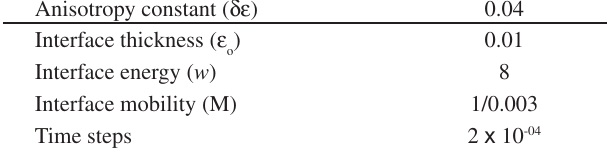
Table 2. Model parameters 2